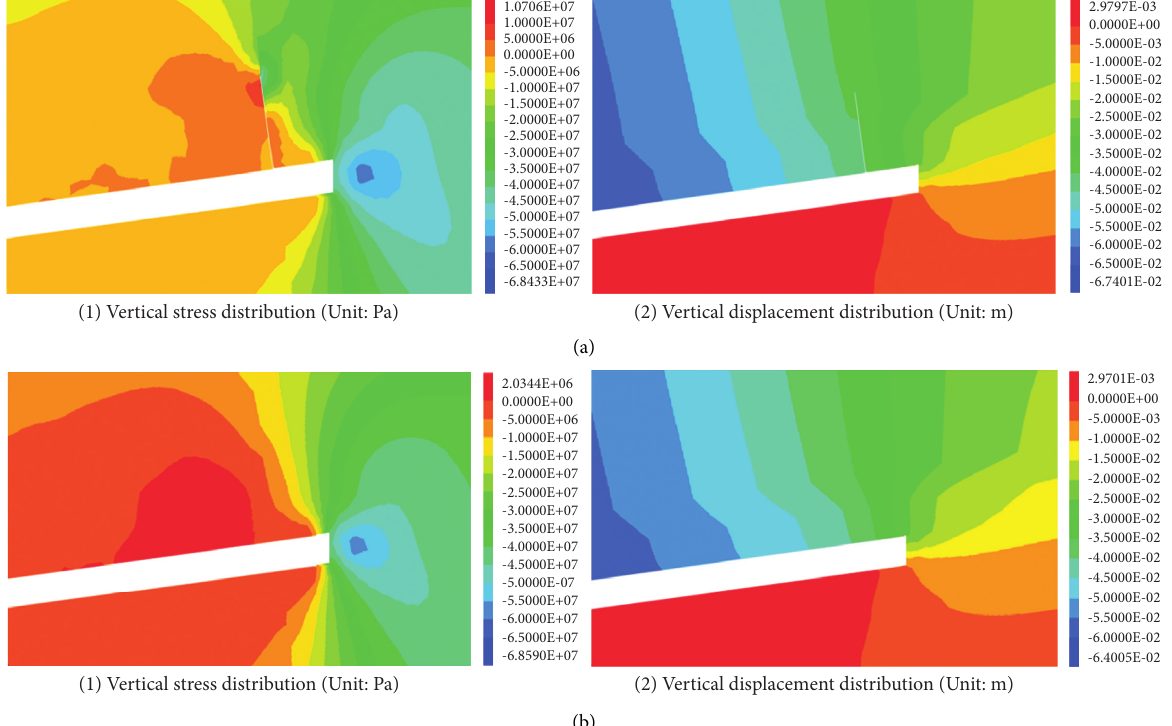
Figure 16: The simulation results of A-A section. (a) Simulation results of vertical stress and displacement under roof cutting. (b) Simulation results of vertical stress and displacement under no roof